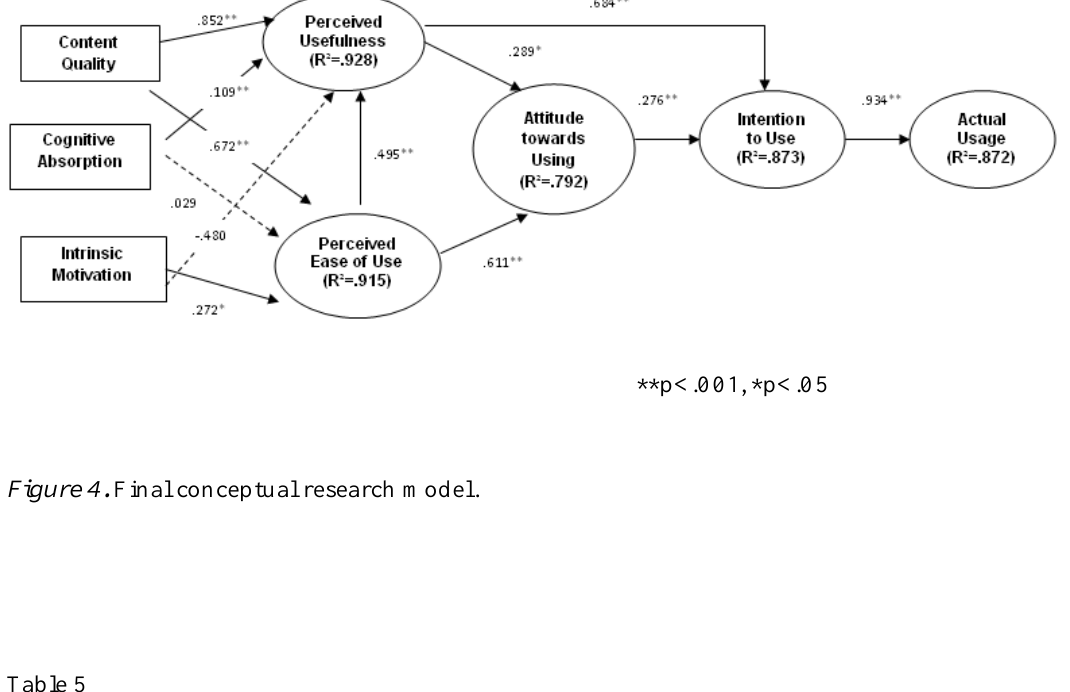
Figure 4. Final conceptual research model.